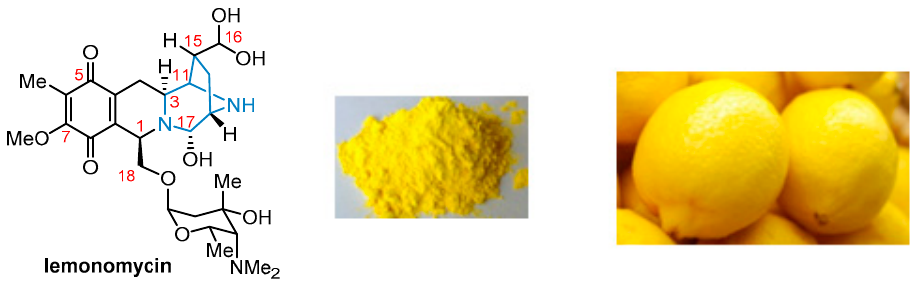
Figure 1. Chemical structure of lemonomycin ( 1 ), isolated sample, and lemon.